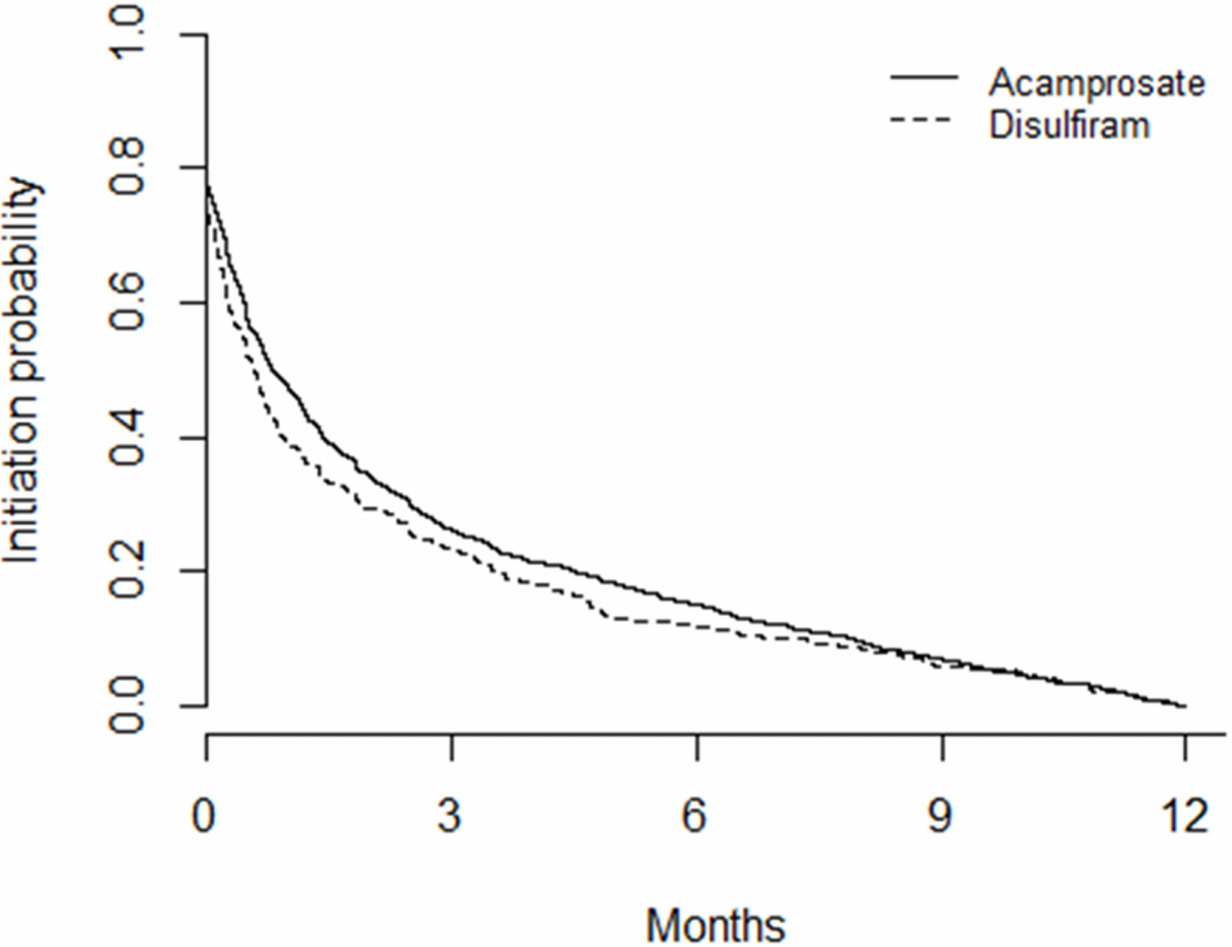
Fig 1. Initiation of prescribing for acamprosate and disulfiram. Number at start of analysis: acamprosate= 1,257; disulfiram = 394.